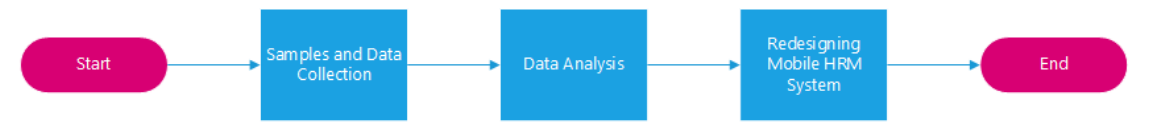
Figure 1. The Flow of Research Methodology